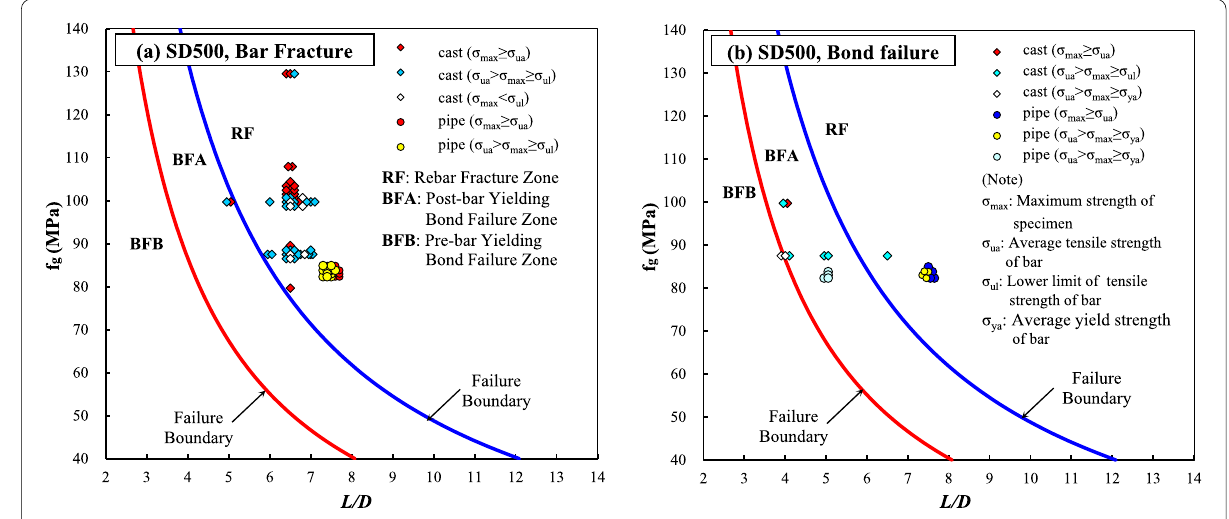
Fig. 6 Failure mode estimation based on Kim equation. (Test specimens with